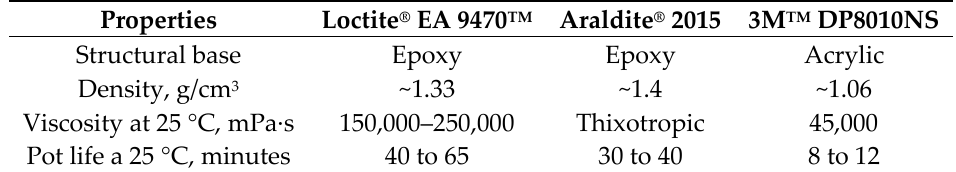
Table 1. Mechanical properties of three different adhesive tested.